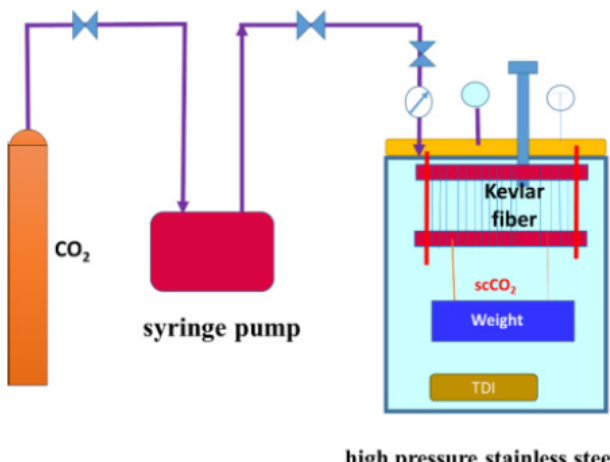
Figure 1. Schematic of experimental setup for treating Kevlar 49 fiber in scCO 2 .